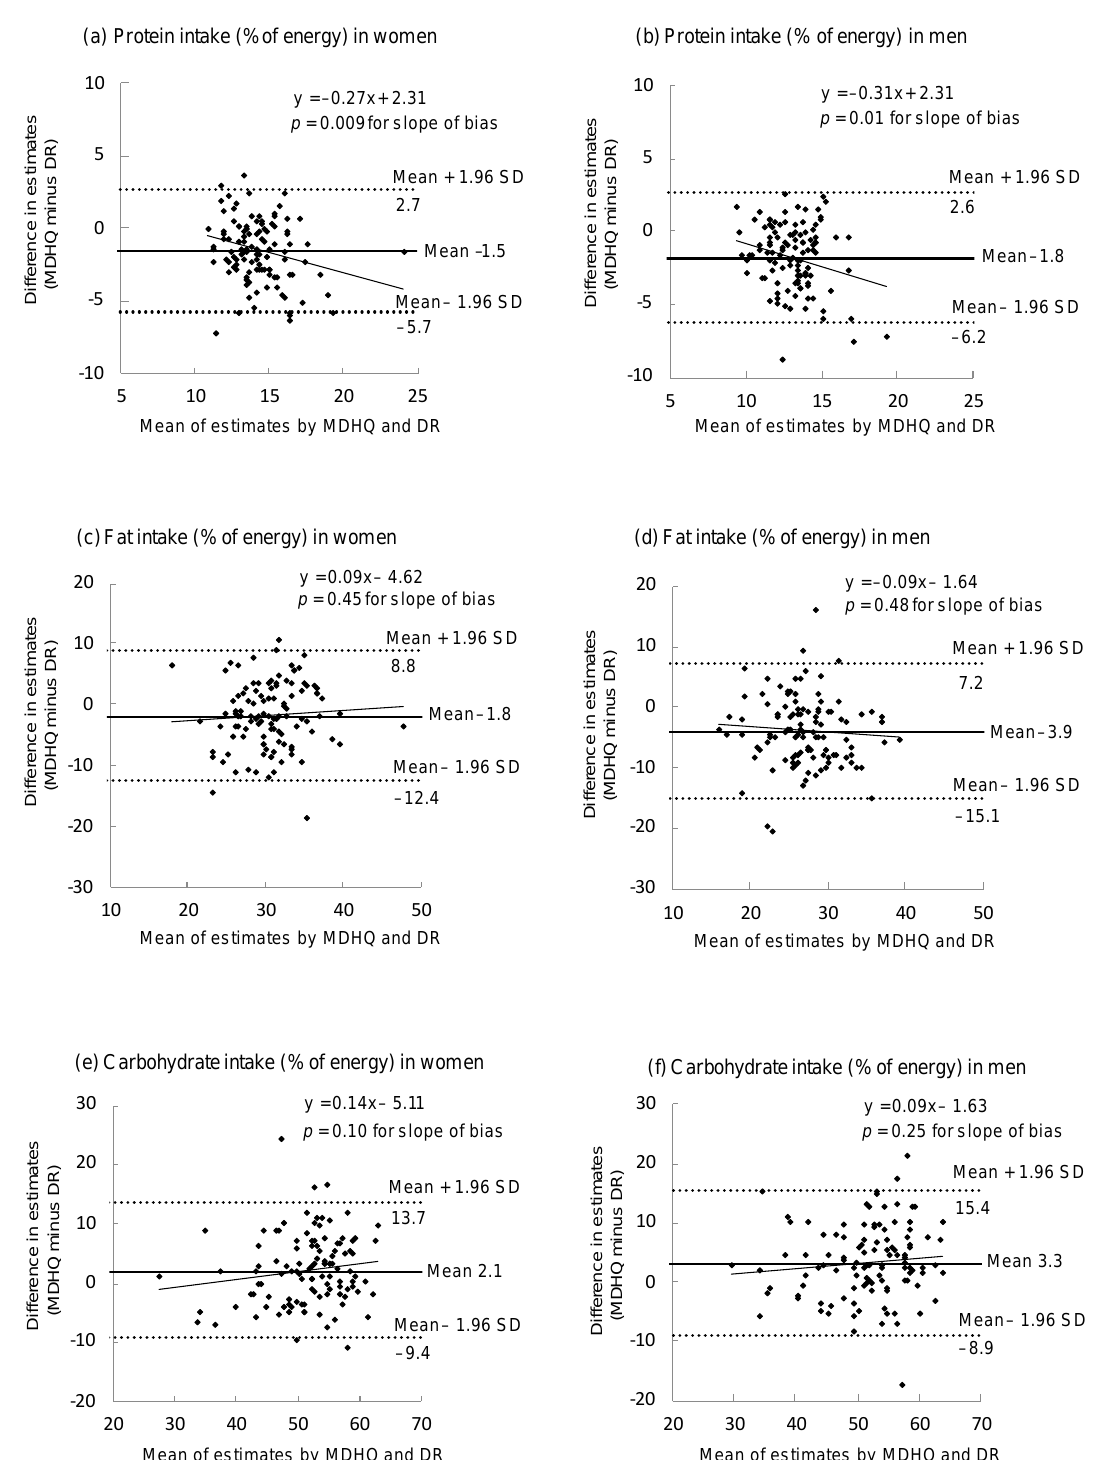
Figure 1. Bland–Altman plots assessing the agreement between estimates of energy-adjusted intakes of protein ( a , b ), fat ( c , d ) and carbohydrate ( e , f ) obtained from the 4-day weighed dietary record (DR) and those obtained from the web version of the Meal-based Diet History Questionnaire (MDHQ) in 111 Japanese women and 111 Japanese men. Energy adjustment was made using the density model. SD, standard deviation.